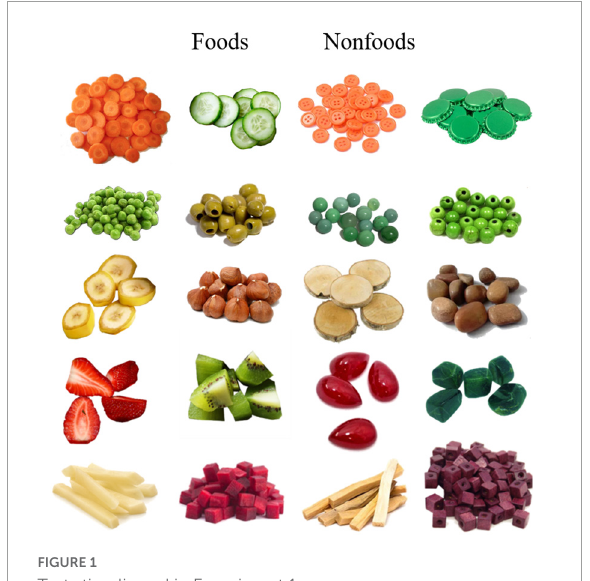
FIGURE1 Test stimuli used in Experiment